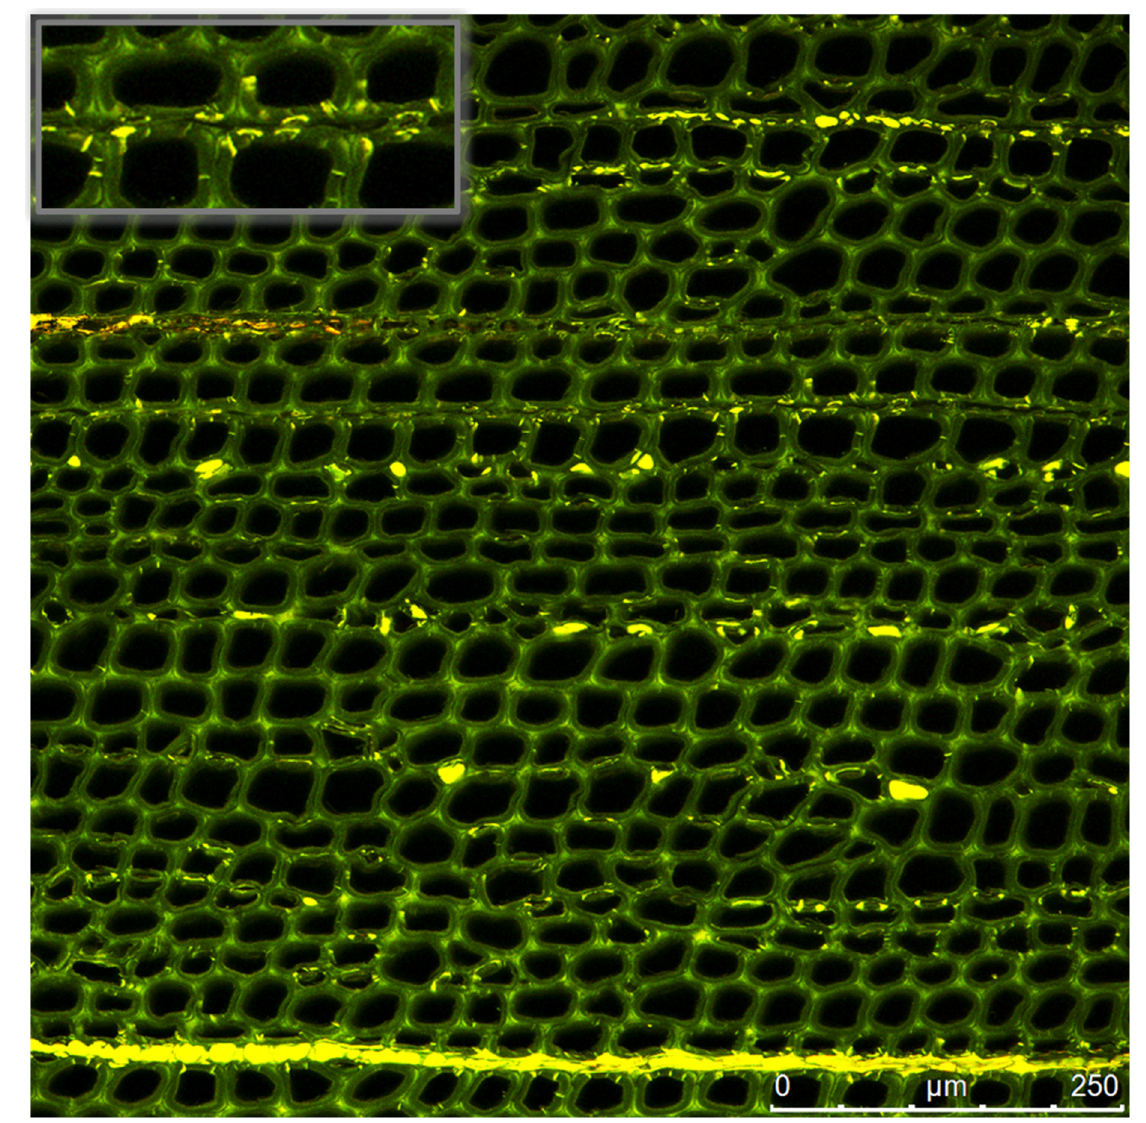
Figure 12. Autofluorescence of wax impregnated wood cells under an optical microscope.